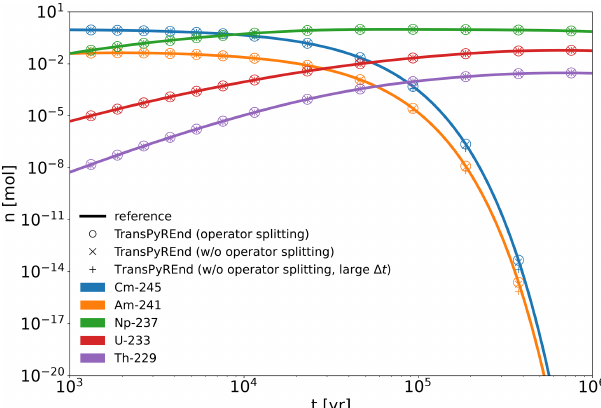
Figure 5. Comparison of a simplified nuclide chain (Actinium chain) between radioactivedecay and TransPyREnd. While radioac- tivedecay (Malins and Lemoine, 2022) solves the pure decay prob- lem, TransPyREnd was run with a simple diffusion+decay setup. In order to compare the two in terms of the conservation of amount of substance, the TransPyREnd concentrations were integrated over the domain to yield the total amount per species. Results are shown with and without operator